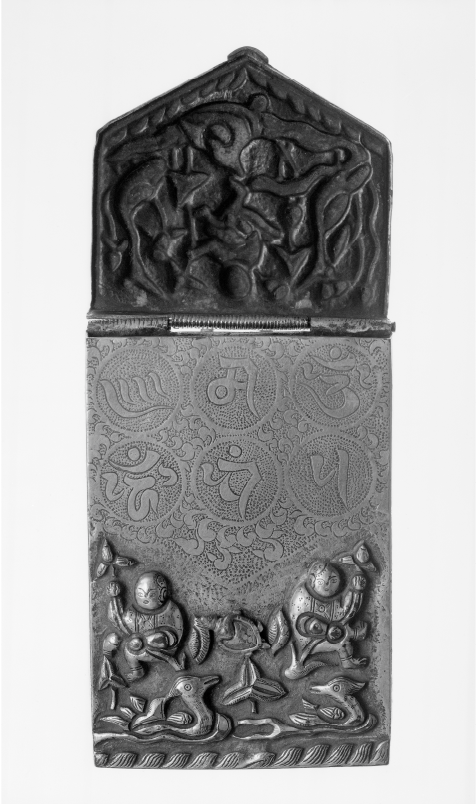
2 Figure 18. Sutra case (when opened). Koryŏ dynasty, twelfth to thirteenth century. L. 9.0 cm, w. 6.1 cm, d. 2.1 cm. Museum of Fine Arts, Boston. Charles Bain Hoyt Fund, 67.1.